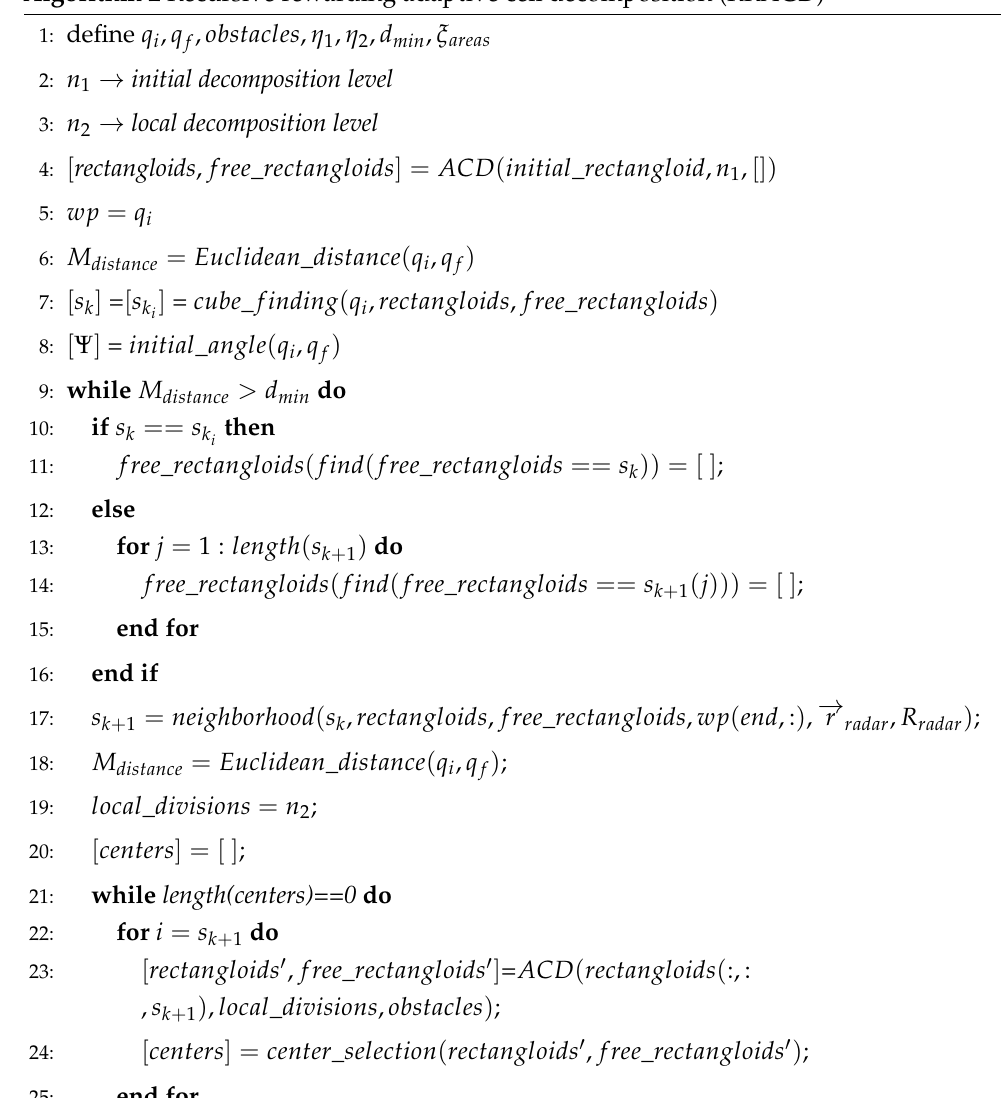
Algorithm 2 Recursive rewarding adaptive cell decomposition